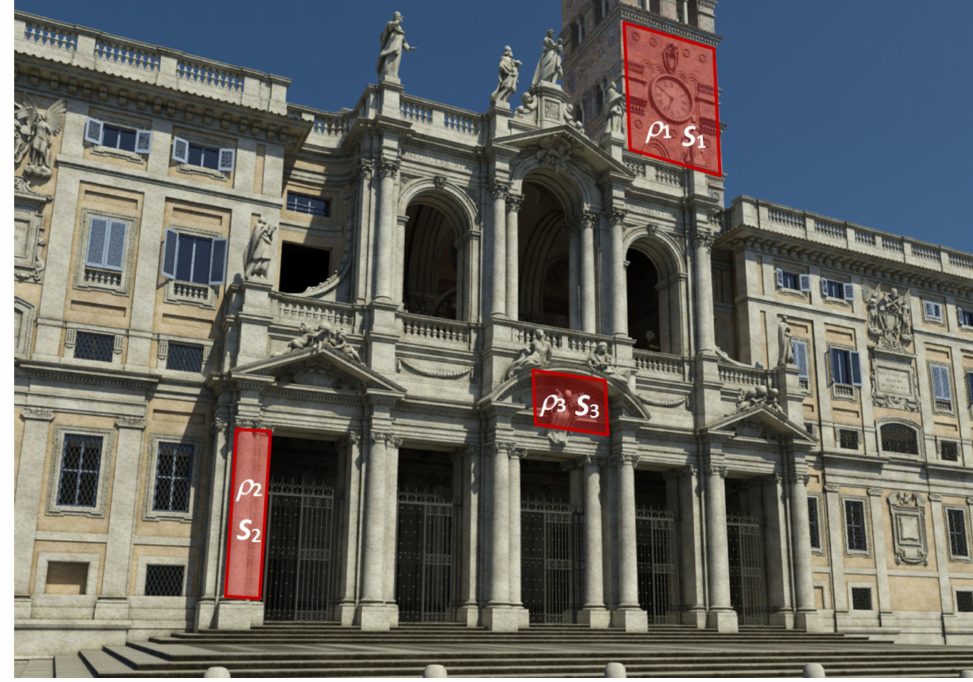
Figure 2. Diversity of materials in the pediment coverage (wiz. Pajda